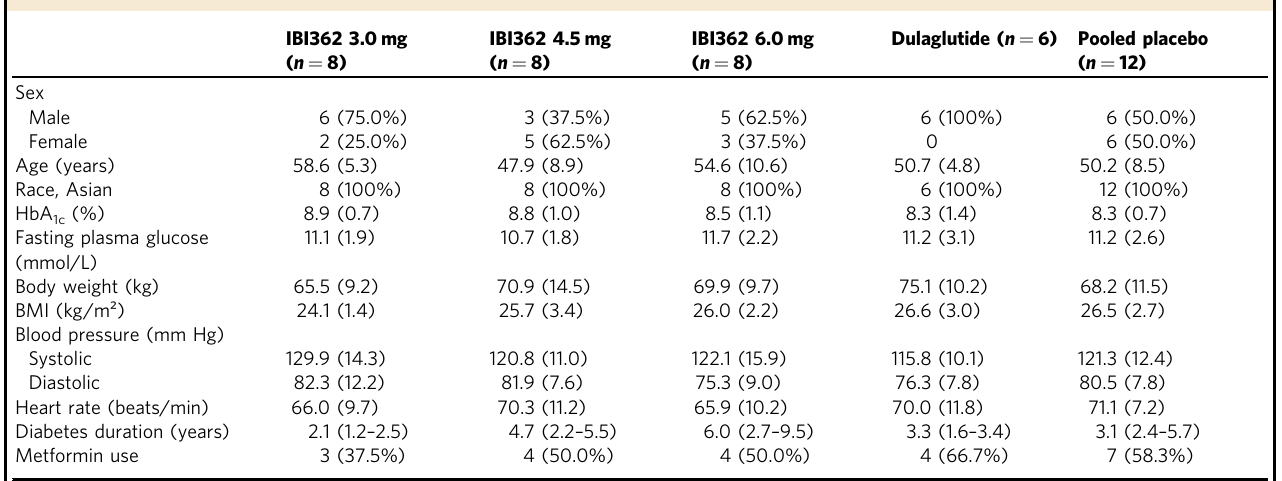
Table 1 Patients demographics and baseline